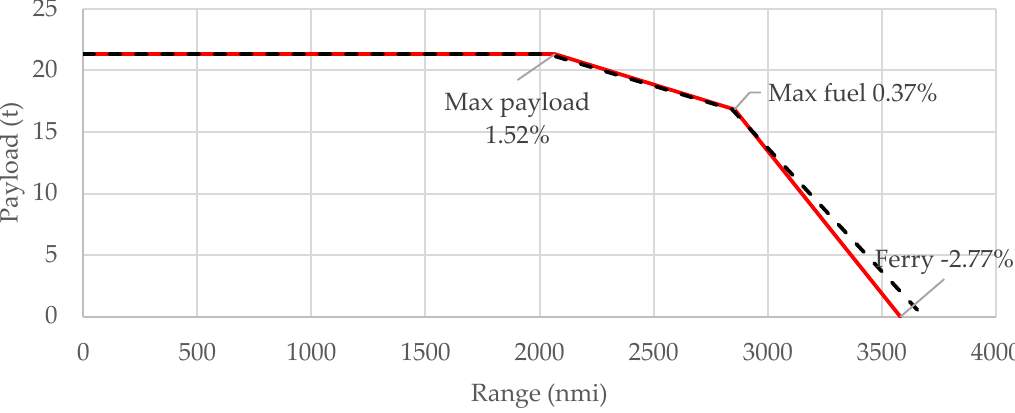
Figure 8. Payload-to-range performance for the baseline 737 800 aircraft.